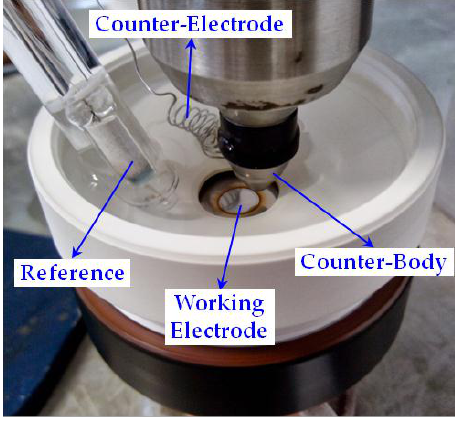
Figure 2. Connections of the electrochemical cell adapted to tribocorrosion testing.